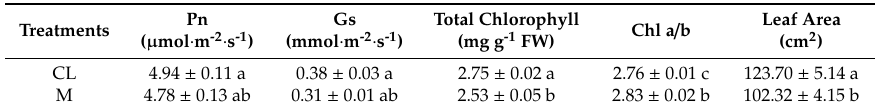
Table 1. Comparison of Pn, Gs, total chlorophyll content, Chl a / b, and leaf area in di ff erent light regimes. ( n = 10 for Pn, Gs, and leaf area. n = 7 for total chlorophyll and Chl a / b.)